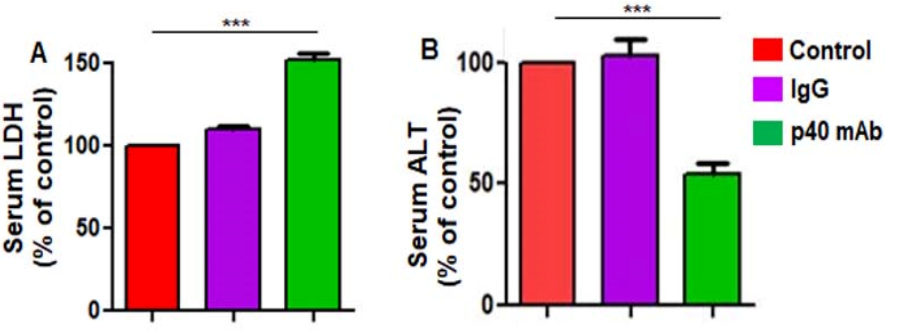
Figure 10. Neutralization of p40 by p40 mAb is not toxic for PDX mice. Female 6–8 week old NSG mice were engrafted TNBC tumor in the flank. After about 4 weeks of engraftment, when tumors of PDX mice were 0.6–0.8 cm 2 in size, mice were treated with p40 mAb and hamster IgG at a dose of 2 mg/kg body wt once a week. After 2 weeks of treatment, the level of LDH ( A ) and ALT ( B ) was assayed in serum using assay kits (Sigma). Results are mean ± SEM of five mice per group. *** p <